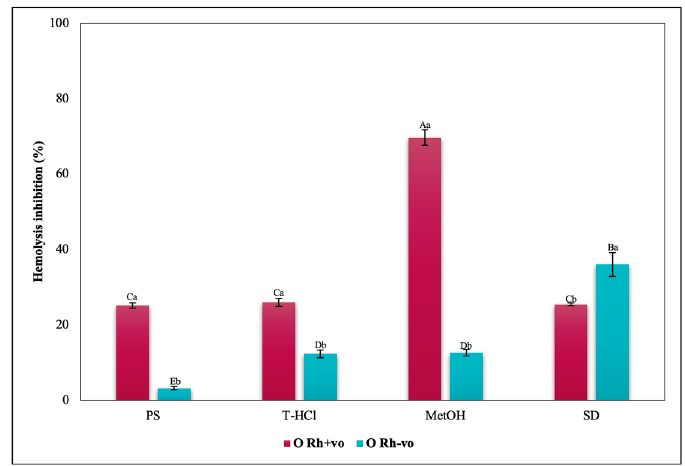
Figure 19. Inhibitory effect of heat-induced hemolysis of P. cruentum extracts on human erythrocytes with different RhD (positive and negative) of O blood group. Different letters represent significant differences in the means between treatments and groups ( p ≤ 0.001). Capital letters represent a two-way ANOVA. Lowercase letters represent a univariate ANOVA between the extracts. PS, extract of physiological solution; T-HCl, 0.5 M Tris-HCl extract; MetOH, 99% methanol extract; SD, sodium diclofenac.